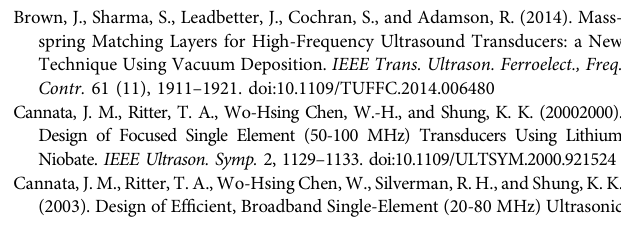
Supplementary fi gure S1 | Schematic diagram of acoustic tweezers (left) and ultrasound scanning microscope (right). Supplementary fi gure S2 | Ceramic grains under the microscope. Supplementary fi gure S3 | A photograph of LN transducer and cross section of piezoelectric layer (left); High resolution ultrasound image of zebra fi sh eye (right). Supplementary fi gure S4 | Cross section of 20 um PZT fi lm. Supplementary fi gureS5| PulseechoandFFTof100 MHzPZTthick fi lmtransducer (top); Experimental pulse echo and FFT of 150 MHz PZT thick fi lm transducer (bottom left);SimulatedpulseechoandFFTof150 MHzPZTthick fi lmtransducer(bottomright). Supplementary fi gure S6 | A photograph of 300 MHz transducer (top left); Schematic diagram of 0 – 3 composite PZT fi lm (top right); time-domain pulse/ echo response (solid line) and frequency spectrum (dashed line) of 100 – 300 MHz transducer (bottom). Supplementary fi gure S7 | A photograph of 193 MHz KNN-LSO needle planar transducer (top left); schematic diagram of 225 MHz KNN/BNT piston focusing transducer(bottomleft);time-domainpulse/echoresponseandfrequencyspectrum of193 MHzKNN-LSOneedleplanartransducer(topright);time-domainpulse/echo response and frequency spectrum of 225 MHz KNN/BNT piston focus transducer (lower right). Supplementary fi gure S8 | Time-domain pulse/echo response (solid line) and frequency spectrum (dashed line) of 170 – 320 MHz KNN/BNT transducer. Supplementary fi gure S9 | Frequency curve of the dielectric coef fi cient of xPMN- PT-(1-x)PZT composite fi lm under different PZT doping ratios (left); time-domain pulse/echo response (solid line) and frequency spectrum (dashed line) of 0.9PMN- PT – 0.1PZT composite fi lm transducer (right). Supplementary fi gure S10 | Ferroelectric hysteresis loops of PMN-PT-PZT composite fi lm under different Ag doping concentration (top left); curve of in fl uence ofAgconcentrationonthedielectricconstantofPMN-PT-PZTcomposite fi lmat1 KHz (topright);aphotographofsilver-dopedPMN-PT-PZTneedletransducer(bottomleft); time-domain pulse/echo response (solid line) and frequency spectrum (dashed line) of silver-doped PMN-PT-PZT needle transducer (bottom right). Supplementary fi gure S11 | Preparation process of spherical pressure focusing transducer. Supplementary fi gure S12 | A photograph of needle type mechanical focused ultrasound transducer (top left); piezoelectric materials after mechanical dimpling under optical microscope (top right); IVUS mechanical focus transducer preparation process (bottom). Supplementary fi gure S13 | Two types of acoustic metasurface lenses and simulation diagram of the focusing effect of two acoustic metasurface lenses. Supplementary fi gure S14 | Schematic and physical image of liquid